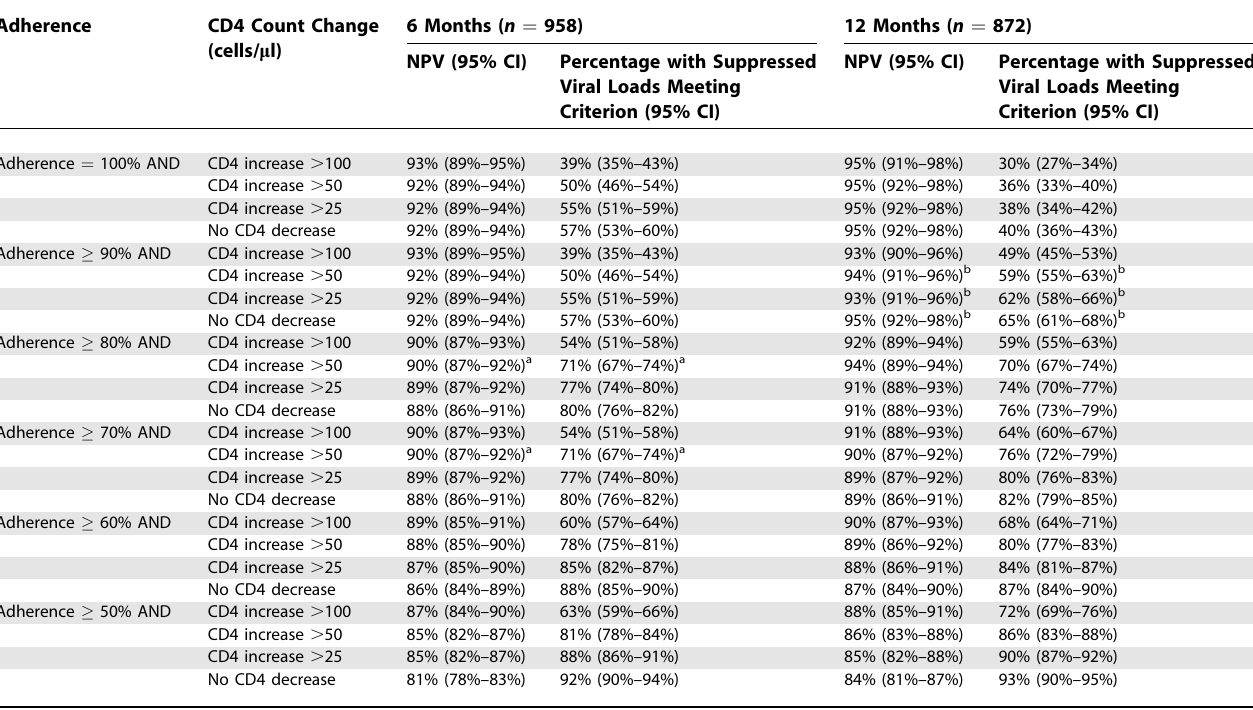
Table 7. NPVs of CD4 Count and Adherence Data Combined for Virologic Failure at 6 and 12 Months